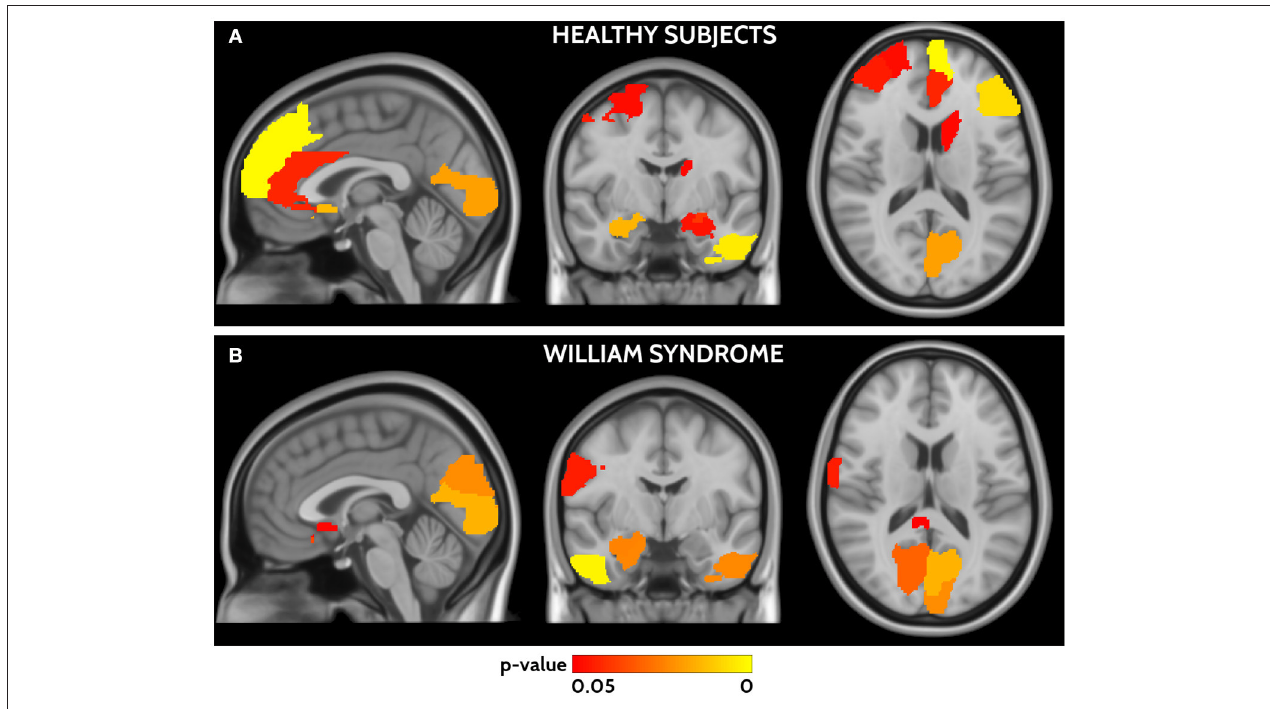
FIGURE 4 | Areas of significant agreement between functional and structural connectivity for HCs (A) and WS (B) are shown in a red yellow scale according to the p -value. HCs show higher agreement in frontal, occipital, and temporal areas, whereas WS patients in parieto-occipital and temporal